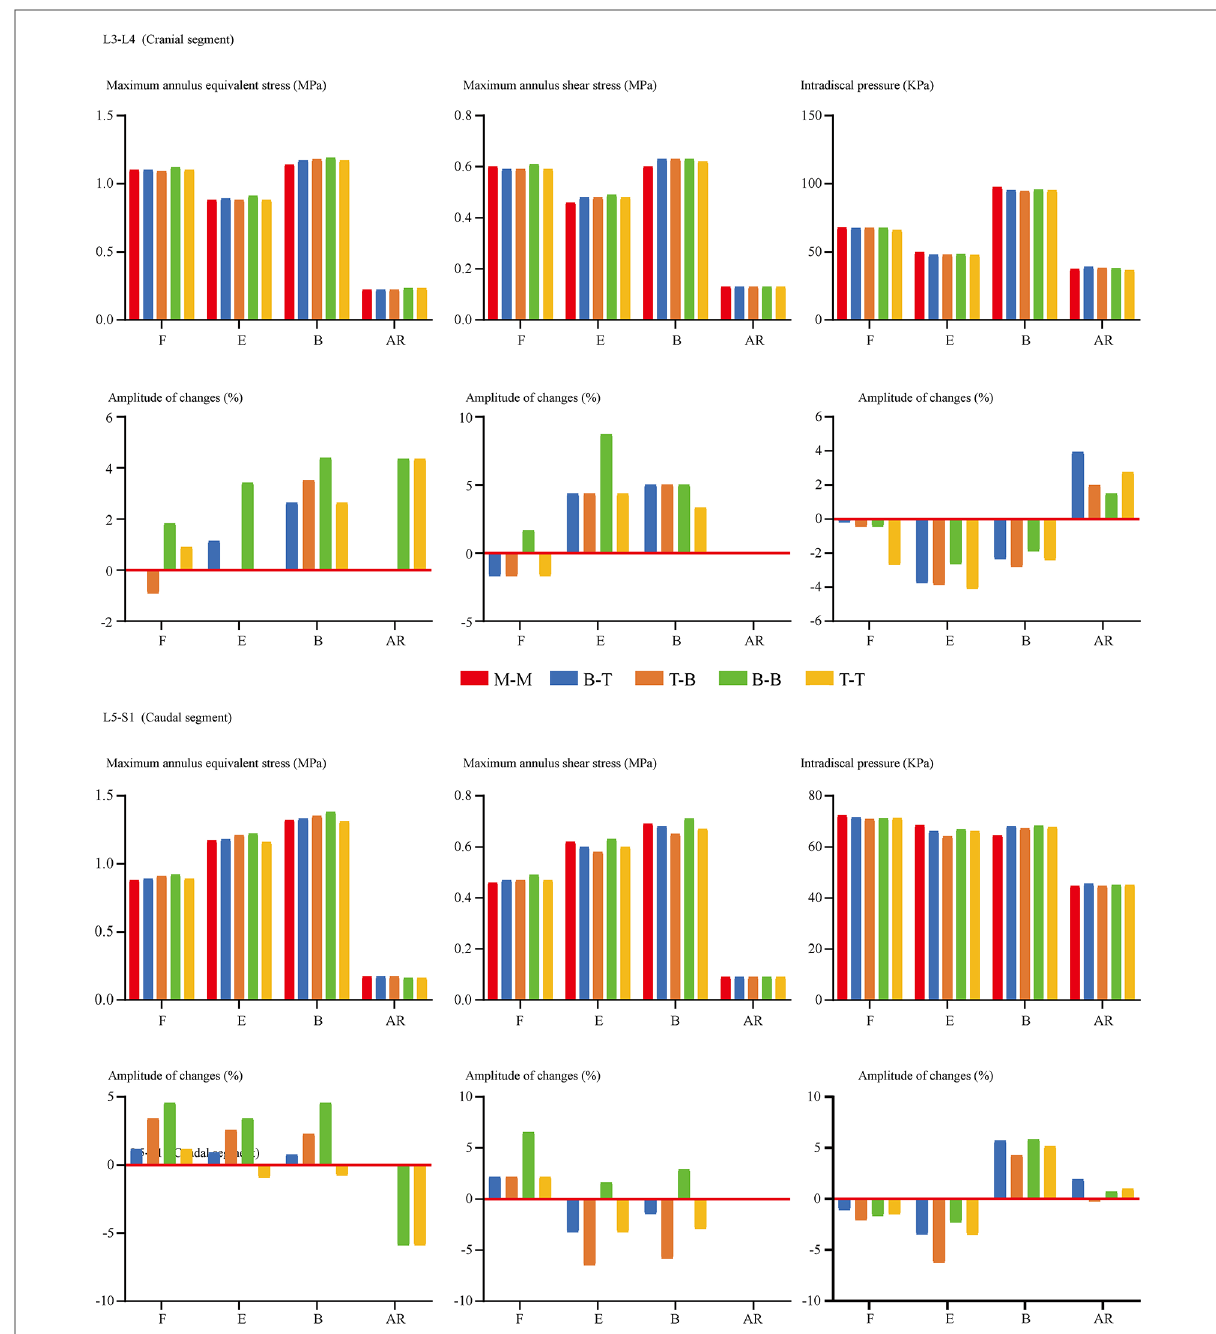
FIGURE 5 Comparison of indicators related to the cranial and caudal disc degeneration between surgical models with different insertional screw positions. F, Flexion; E, Extension; B, Bending; AR, Axial